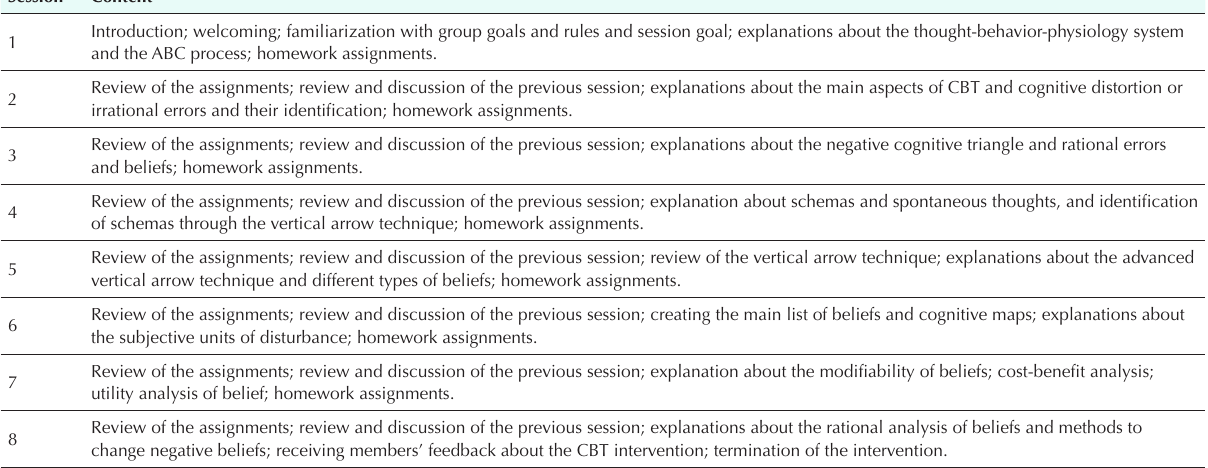
Table 1. Content of therapy sessions Session Content